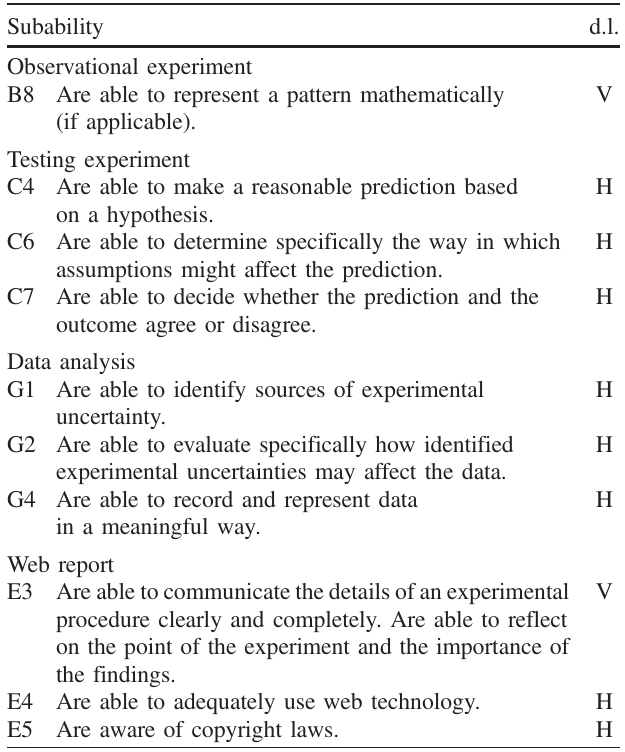
TABLE XII. The subabilities that take the most iterations to develop. Included are only subabilities assigned a difficulty level (d.l.) of H or V. See text for explanation.